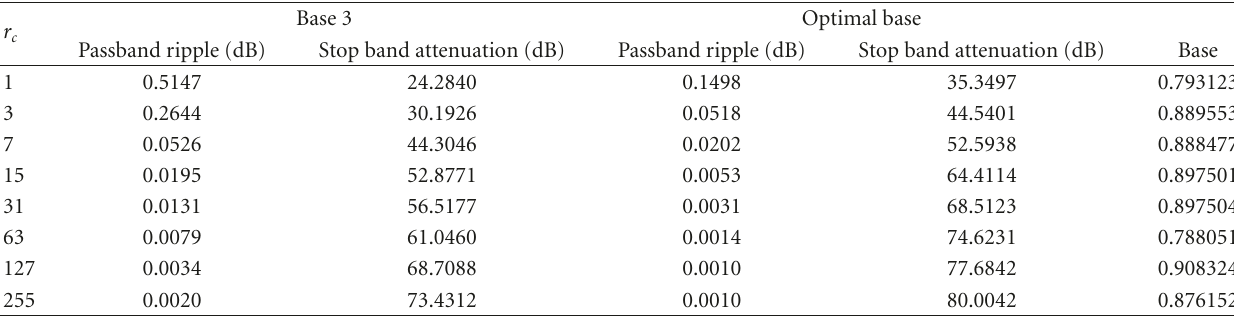
Table 1: Filter performance for ternary and optimal base (single-digit).